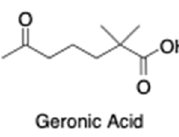
Figure 2. Geronic acid is an apocarotenoid product characteristic of OxBC that is used as a proxy marker compound for estimating OxBC.